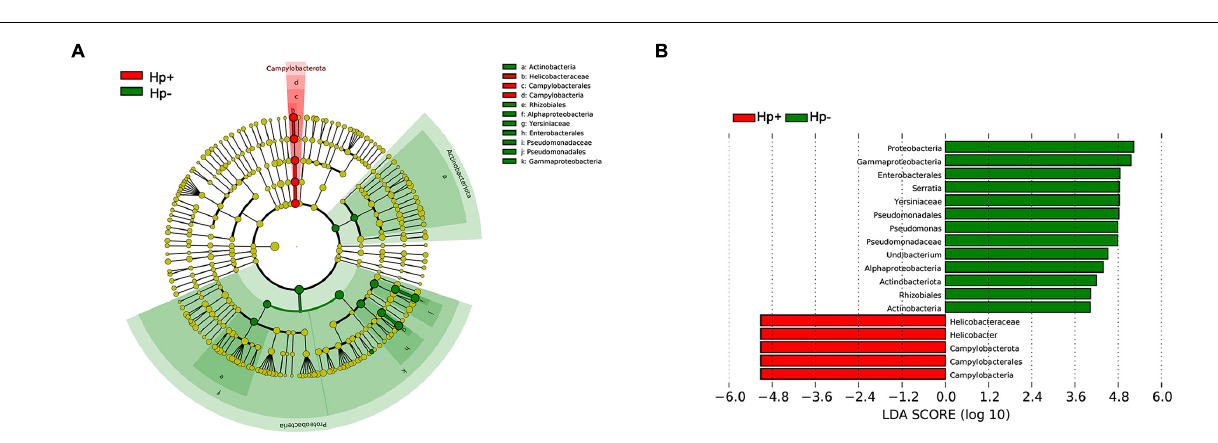
FIGURE 4 | The linear discriminant analysis effect size (LEfSe) identifies the taxa with the greatest differences of gastric microbiota abundance in children with duodenal ulcer between H. pylori positive group and H. pylori negative group. (A) Cladogram of taxonomic distribution in different levels between the two groups. (B) The histogram of the linear discriminant analysis (LDA) scores in significantly differential bacteria between the two groups. Hp+, H. pylori -positive group; Hp-, H. pylori -negative